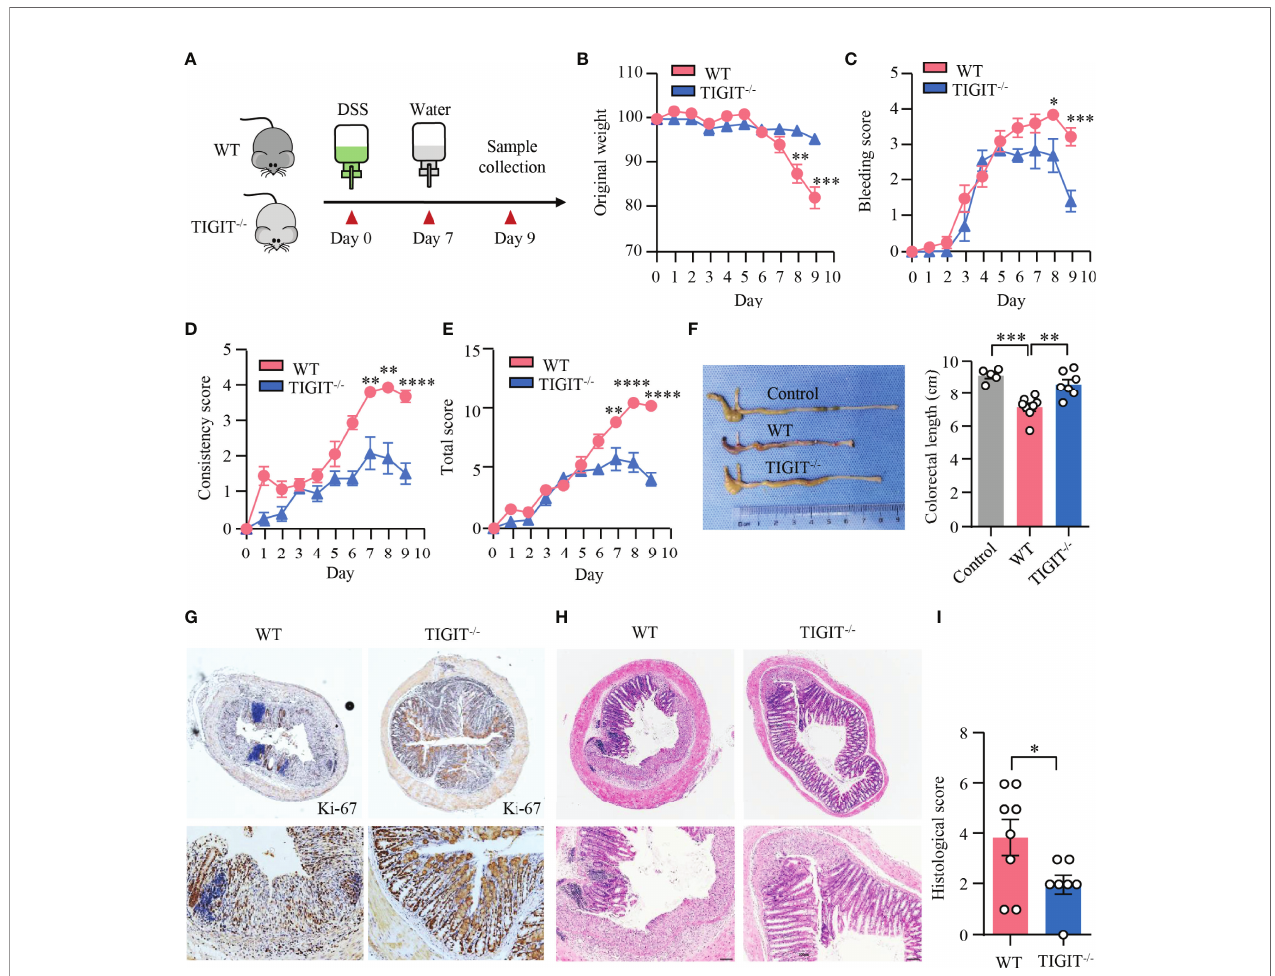
FIGURE 6 | TIGIT de fi ciency protected mice from DSS-induced colitis. (A) Schematic representation of experiment design. Male littermates of TIGIT − / − or WT mice were fed with DSS to induce colitis. Loss of body weight (B) , bleeding score (C) , stool consistency score (D) , and total score of disease activity index (E) were measured daily. (F) Colon length was measured at the end of the experiment and representative images of the colons from TIGIT − / − or WT mice with DSS-induced colitis or control mice without DSS-induced colitis were shown. (G) Colon sections were stained with antibody against Ki-67 and visualized using HRP-conjugated secondary antibody. Representative images of Ki-67 staining in colonic tissues from TIGIT − / − or WT mice with DSS-induced colitis were shown. Original magni fi cation: ×4 (top), 20× (bottom). (H, I) Representative H&E images of the colon (H) and histological scores (I) . Original magni fi cation: ×4 (top), ×10 (bottom). WT (n = 8) or TIGIT − / − mice (n = 7). Data are means ± SEM. * p < 0.05, ** p < 0.05, *** p < 0.001, **** p < 0.0001 by Student ’ s